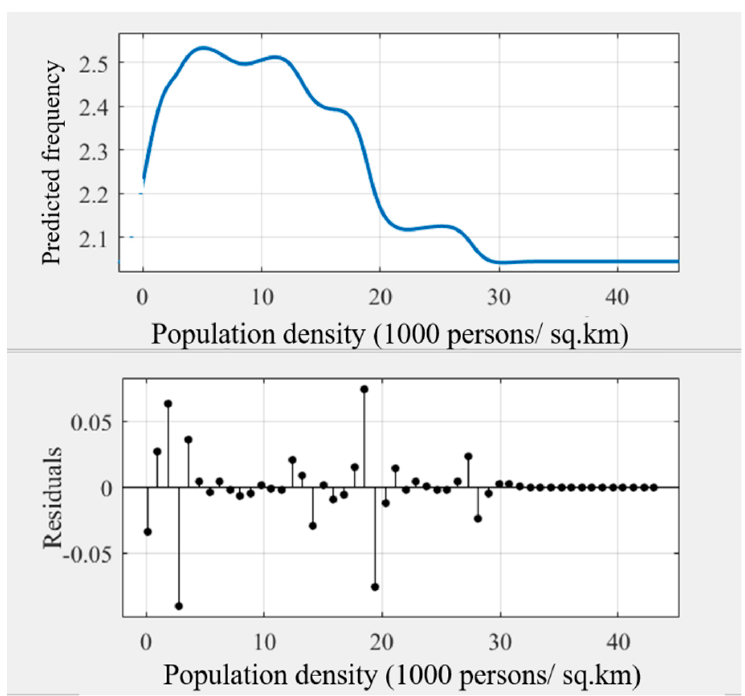
Figure 4. Nonlinear associations between POPDEN (population density) and cycling frequency among older adults.